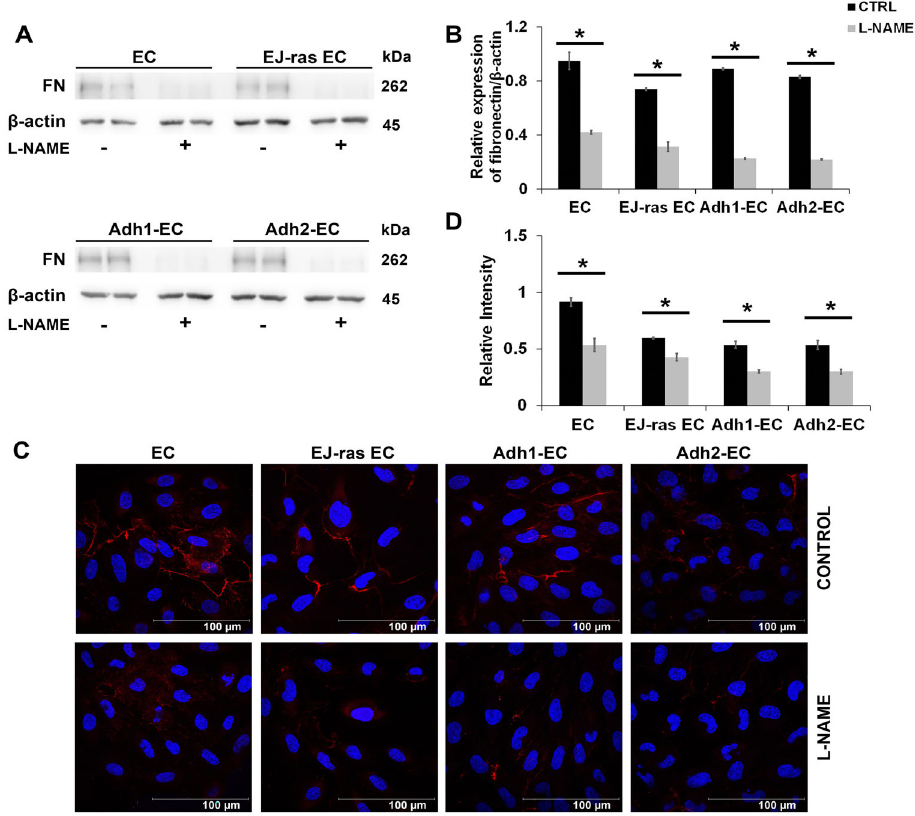
Figure 4. L-NAME treatment decreased fi bronectin expression in EC-derived cell lines. A , Western blot images of fi bronectin expression after NO release inhibition in EC, EJ-ras EC, Adh1-EC, and Adh2-EC cells. B , Histogram depicting fi bronectin protein levels normalized to b -actin. The experiments were performed in duplicate and repeated twice. C , Immuno fl uorescent analysis of fi bronectin by immunocytochemistry of EC, EJ-ras EC, Adh1-EC, and Adh-2 EC cells after L-NAME treatment (scale bar 100 m m). D , Histogram depicting fi bronectin protein levels normalized by DAPI fl uorescence. Fibronectin was stained with anti- fi bronectin antibody followed by secondary Alexa Fluor 633-labelled antibody (red). Nucleus is stained with DAPI (blue). Each fi gure shows the best image of two experiments. CTRL: Control; EC: parental endothelial cells; EJ-ras EC: EJ-ras transfected endothelial cells; Adh1-EC and Adh2-EC: anoikis-resistant endothelial cells. Data are reported as means ± SE. *P o 0.05 compared to control ( t